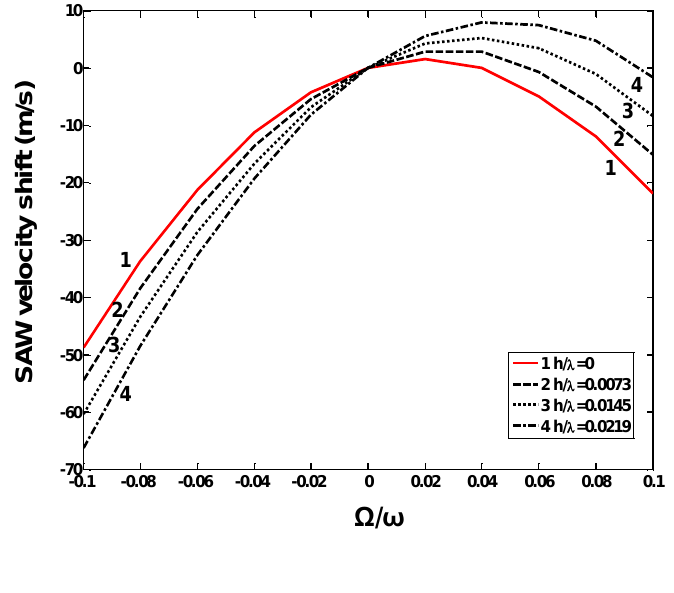
Figure 3. The SAW velocity shift depending on the normalized rotation in case Cu dots with various normalized thickness